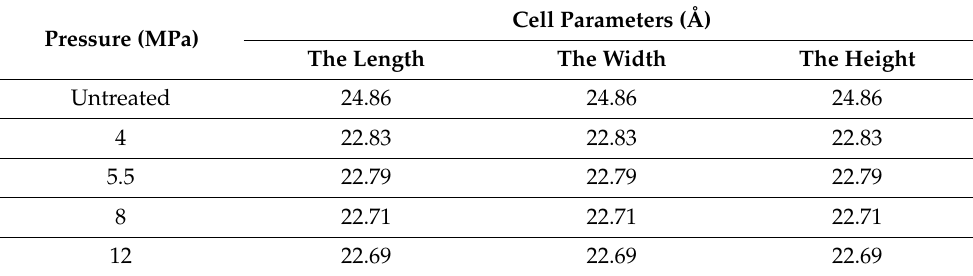
Table 1. Cell parameters of water–cellulose model.